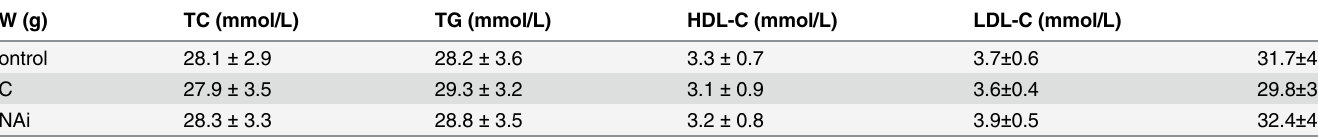
Table 1. Body weight, plasma TC, TG, HDL-C and LDL-C levels among all groups. BW (g) TC (mmol/L)